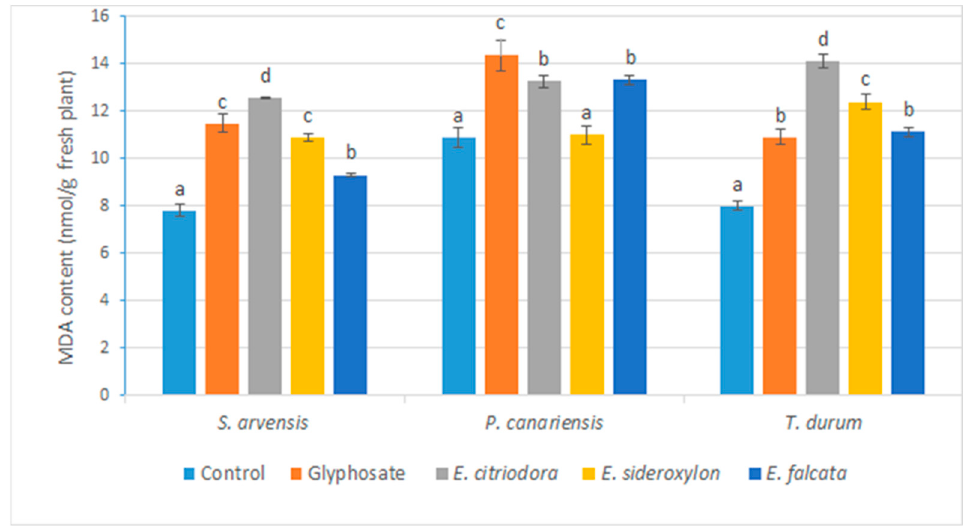
Figure 7. Effects of Eucalyptus species essential oils and glyphosate on MDA content as nmol/g fresh tested plants measured five days after application. Error bars and letters on graphs represent standard error means and significant differences at p ≤ 0.05 through Student–Newman–Keuls.